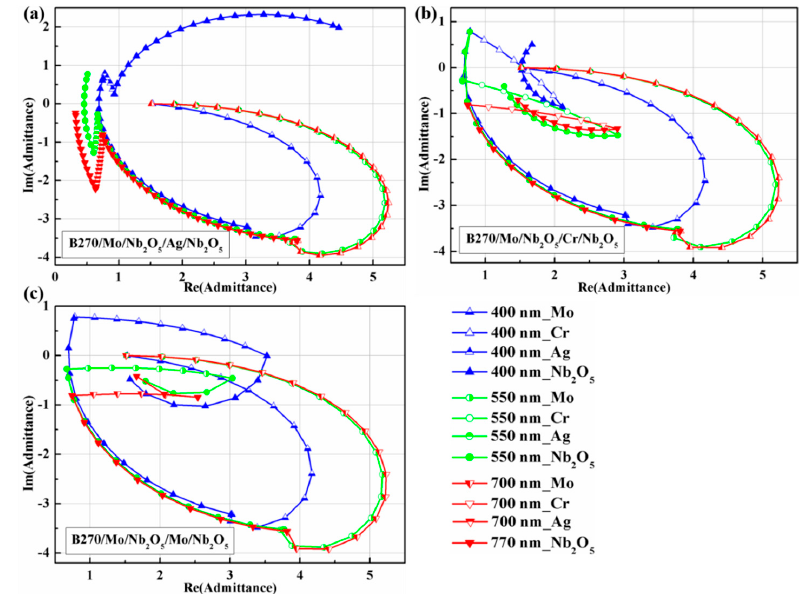
Figure 5. Admittance loci of solar selective absorber using ( a ) Ag, ( b ) Cr, and ( c ) Mo as the absorption layer for wavelengths of 400 nm, 550 nm, and 700 nm.